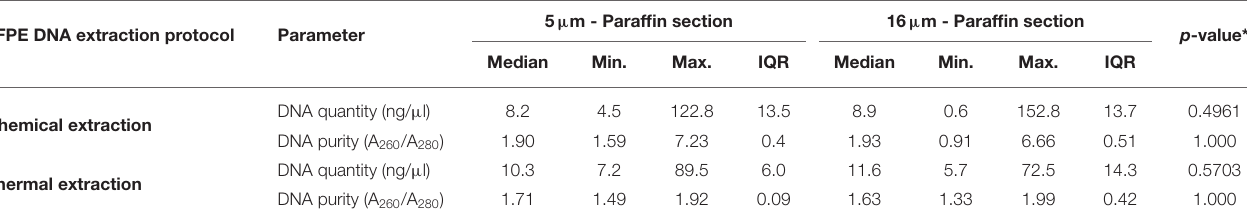
TABLE 1A | Comparison of chemical and thermal DNA extraction protocols in six FFPE pellet samples of Sporothrix sp. and negative controls, using the two paraffin sectioning protocols (5 µ m and 16 µ m), in relation to the DNA concentration (ng/ µ L) and the degree of DNA purity (A 260 /A 280 nm ratio). FFPE DNA extraction protocol